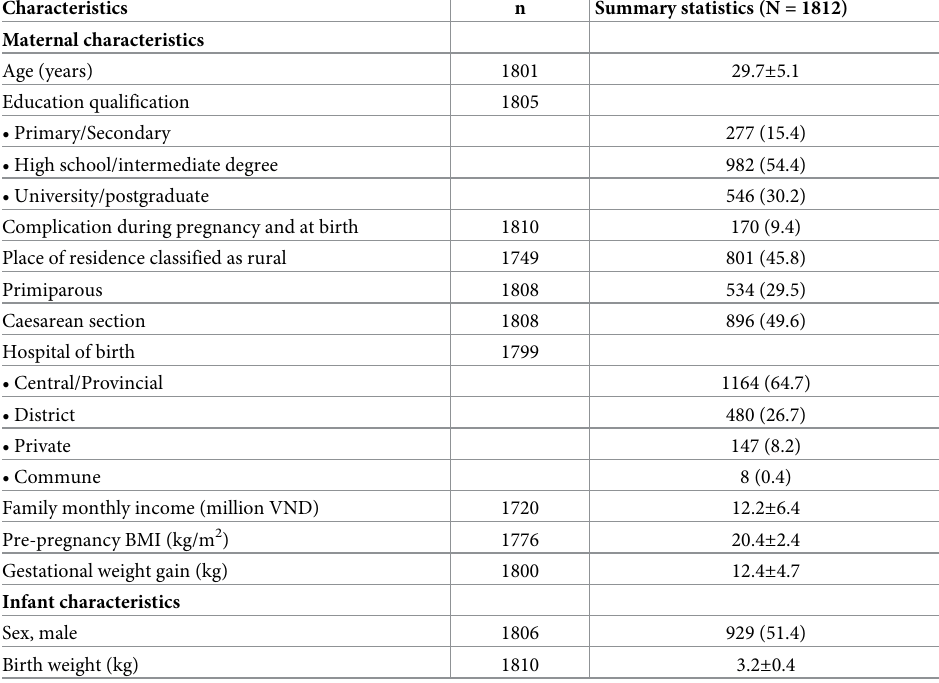
Table 1. Maternal and infant